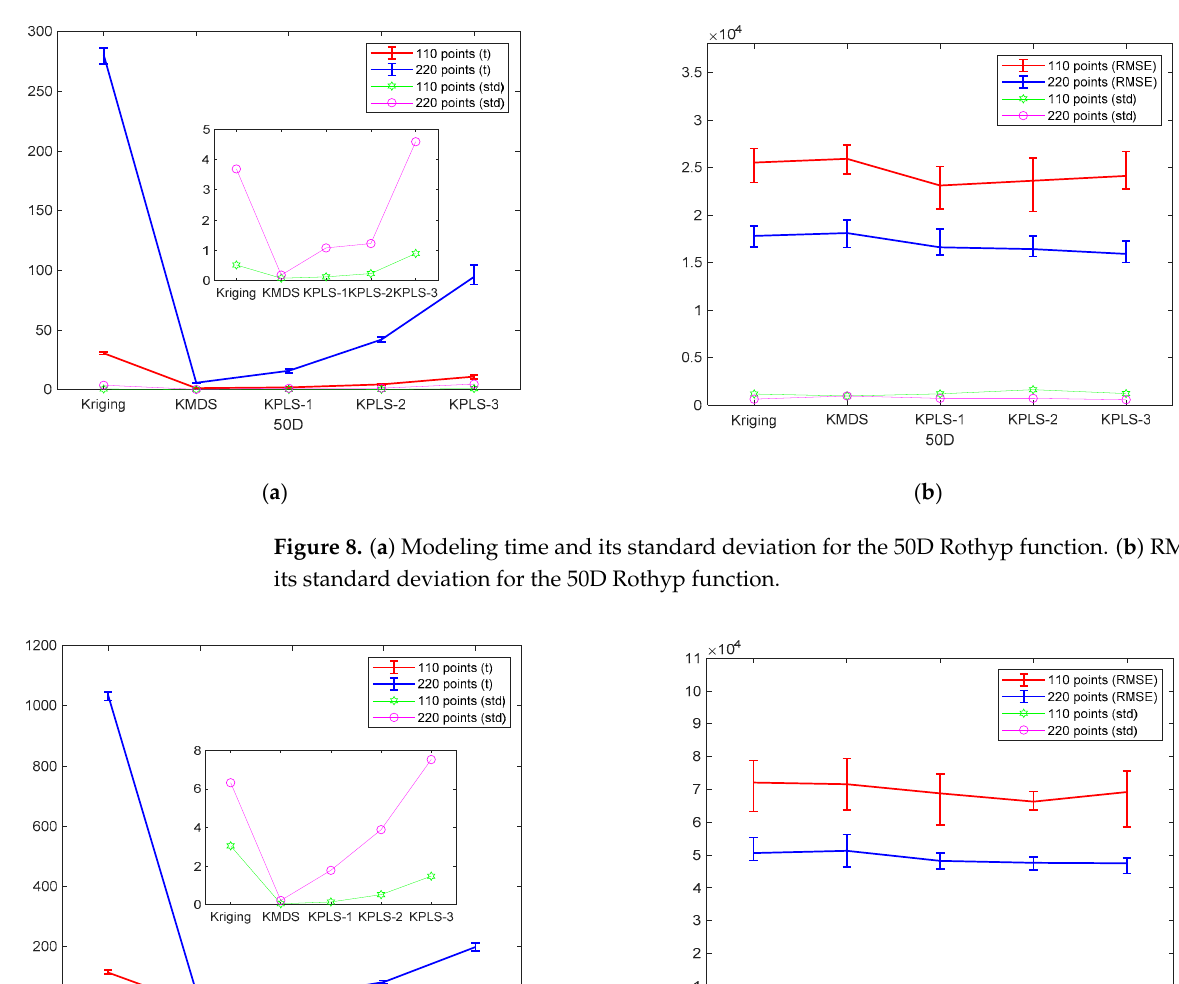
Figure 7. ( a ) The average change trend for the modeling time for the 100D Rothyp. ( b ) The average change trend for RMSE for the 100D Rothyp.